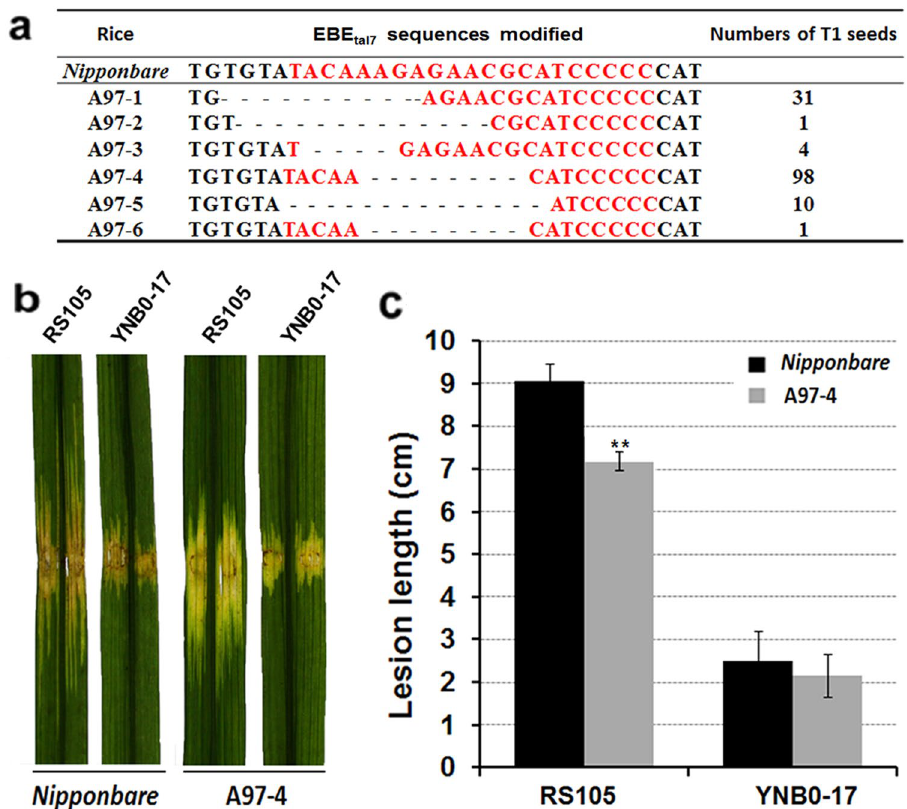
Figure 6. TALEN-modified editing of EBE tal7 in rice gene Os 09g29100 . ( a ) Colored letters indicate the nucleotide preference of Tal7 according to the TALE code. Letter height represents the preferences relative to other nucleotides for the RVD (generated with TALGetter: http://galaxy.informatik.uni-halle.de/root?tool_ id = TALgetter). The RVDs of Tal7 DNA-binding domain and nucleotide sequence of the EBE tal7 region in Os09g29100 are shown. The table shows the EBE tal7 sequences in Nipponbare and six TALEN-edited lines (A97-1, A97-2, A97-3, A97-4, A97-5, and A97-6). The EBE tal7 sequence is shown in red font; the dashed lines ( − ) indicate deletions obtained from TALEN editing. The number of T1 seeds obtained from each line is indicated. ( b ) Inoculation of Xoc RS105 (hypervirulent) and YNB0-17 (hypovirulent) to rice cv. Nipponbare and transgenic line A97-4 containing the TALEN-modified EBE tal7 in Os09g29100 . Strains YNB0-17 and RS105 (OD 600 = 0.5) were inoculated to adult rice plants with needleless syringes and photographed 14 dpi. ( c ) Disease lesion lengths on cv. Nipponbare and rice transgenic line A97-4 at 14 dpi. Column height represents mean lesion length and vertical bars show the ± SD from five replicate plants. All experiments were repeated three times, and similar results were